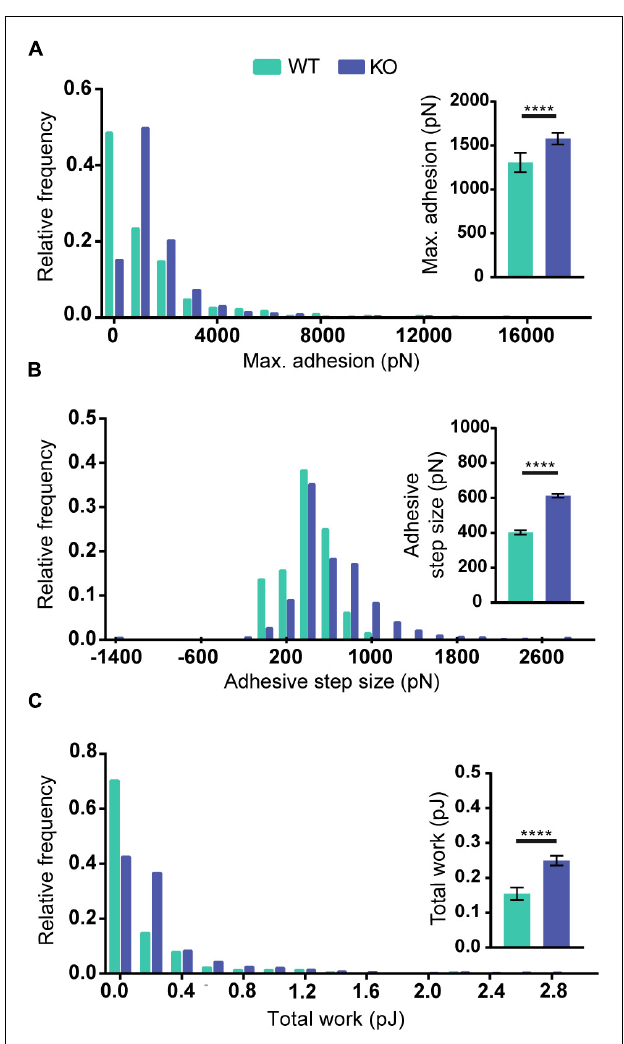
FIGURE 11 | Poly (ADP-ribose) polymerase 1 loss increases NPC adhesiveness to N-cadherin. Maximum adhesion (A) , adhesive step size (B) , and total work (C) are higher in NPCs from KOs than from WTs ( n = 229–742 from 4 WT and 5 KO biological replicates). Distributions are significantly different ( p < 0.0001 by Kolmogorov–Smirnov test). Inset graphs show average values. **** p < 0.0001 by Mann–Whitney